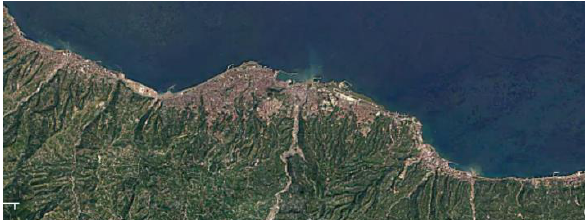
Figure 8. Google Timelapse Image of Trabzon (2006)